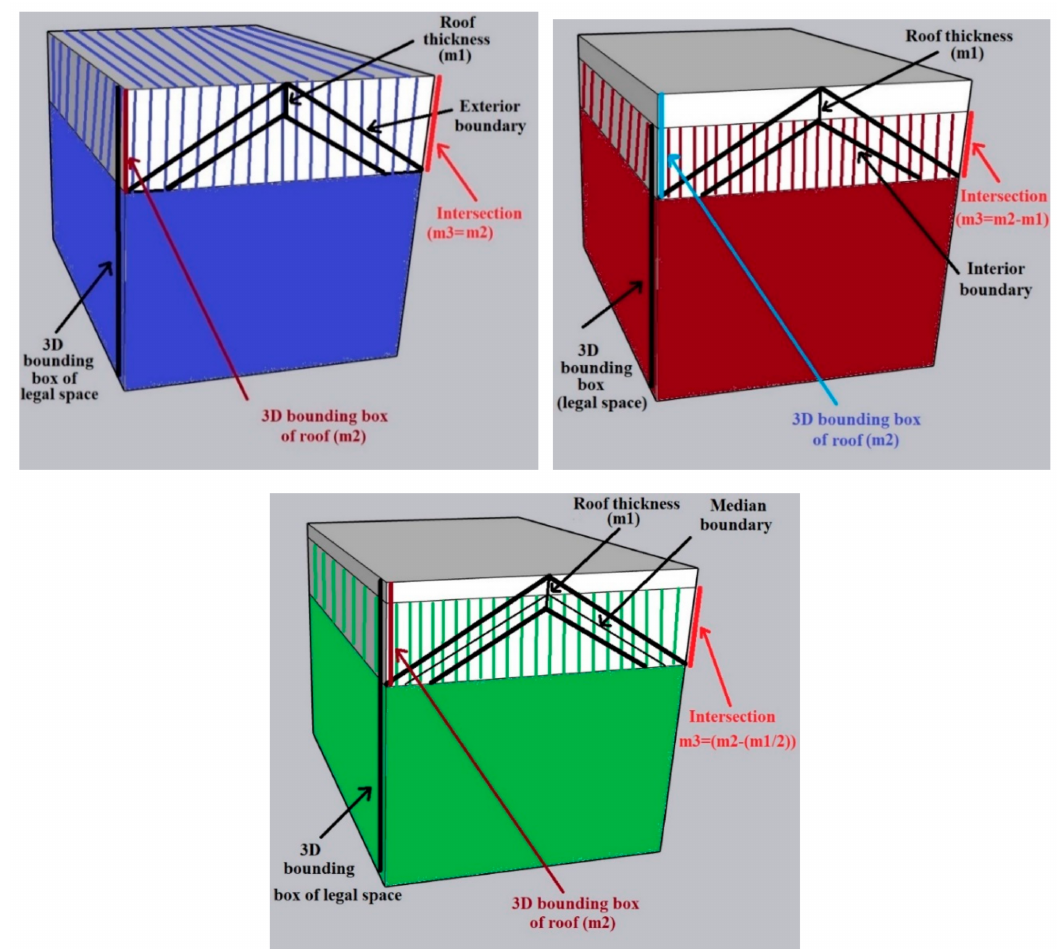
Figure 5. Using (thickness of intersection between 3D bounding box of roof and 3D bounding box of legal space) as a criterion for differentiating among different types of property boundaries (an oblique